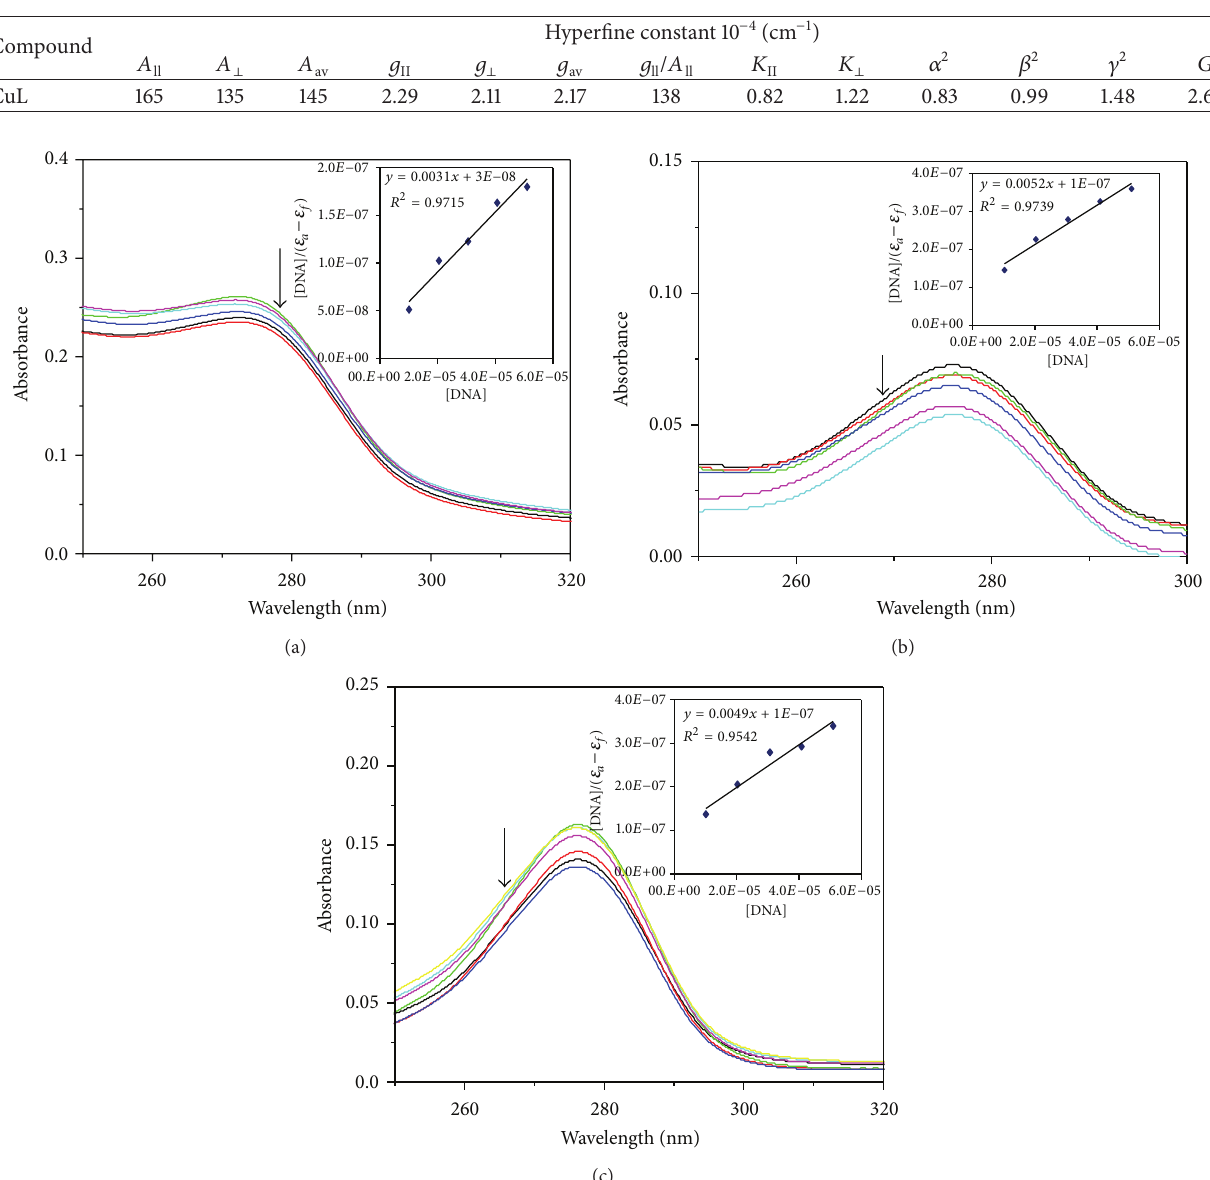
Figure 2: UV-Vis absorption spectra of (a) CuL, (b) NiL, and (c) ZnL (10 𝜇 M) in the absence and presence of increasing amounts of CT DNA; [DNA] = 0–60 𝜇 M. The arrow indicates the absorbance change upon increasing DNA concentration. The inset is a plot of [DNA]/( 𝜀 𝑎 − 𝜀 𝑓 ) versus